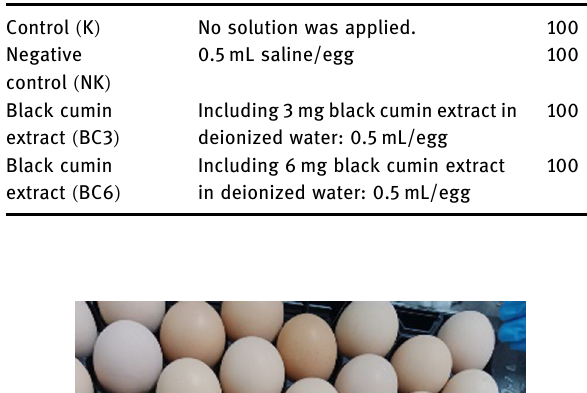
Figure 2: Measurement of chick